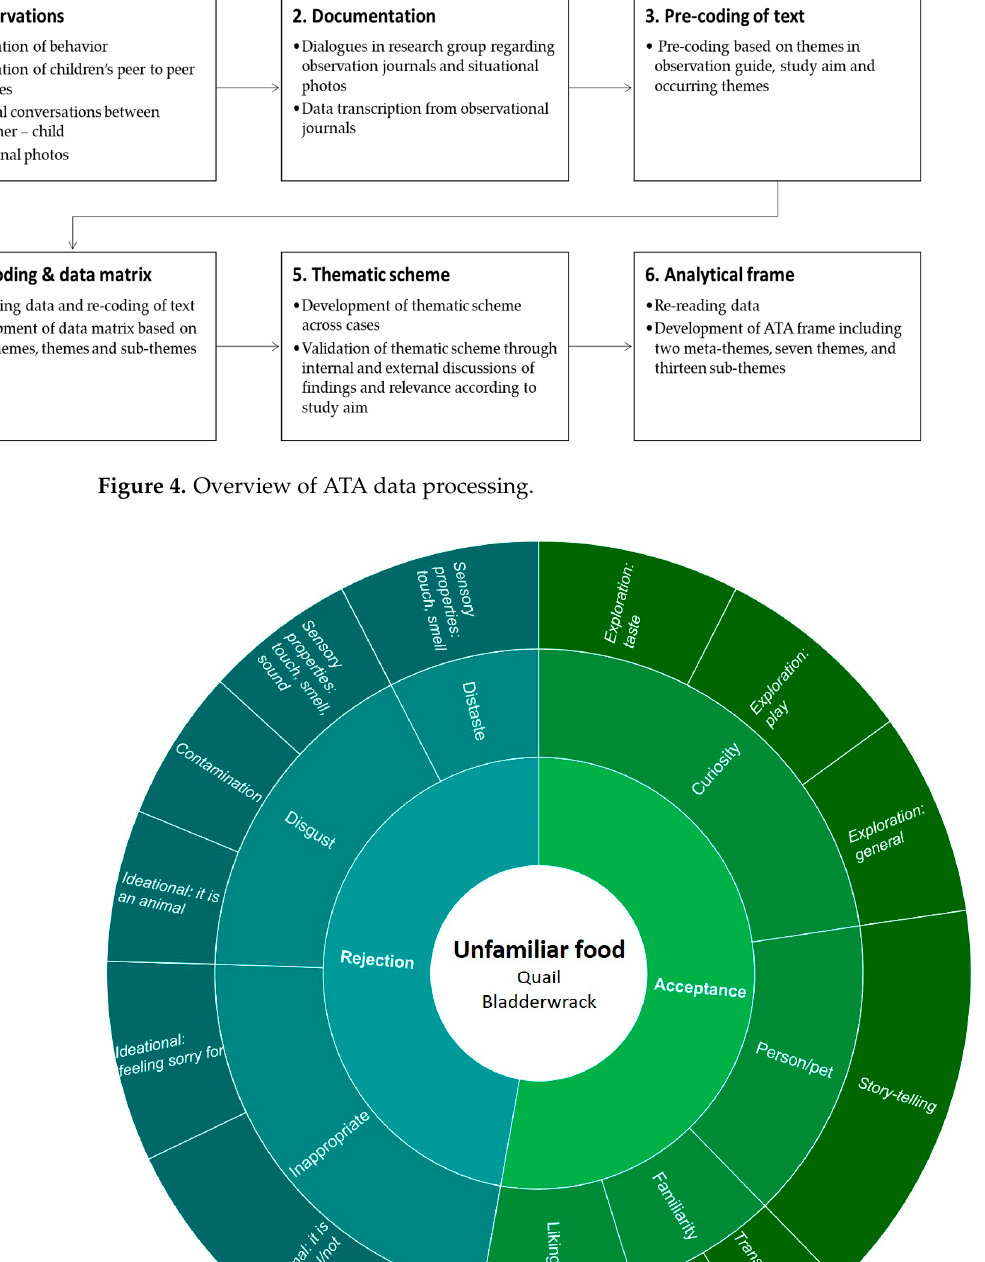
Figure 4. Overview of ATA data processing.